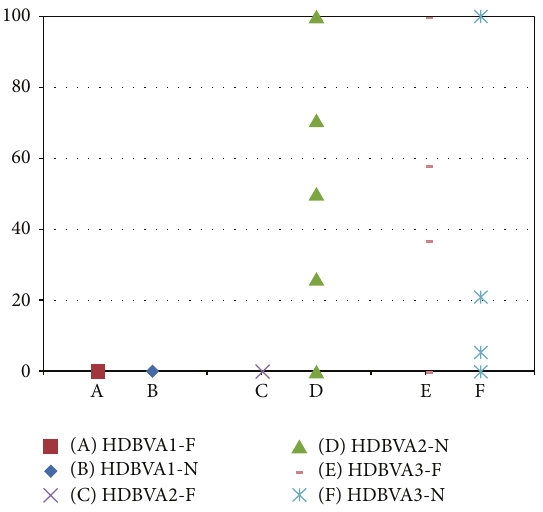
Figure 18: Out-Range slider displacement percentages of case Figure 10(d).